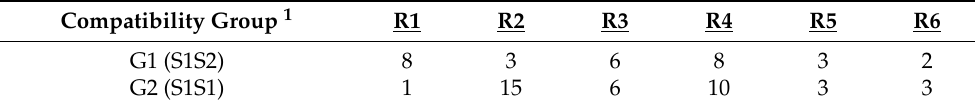
Table 4. Occurrences of S-alleles in G1 and G2 groups (raw data).